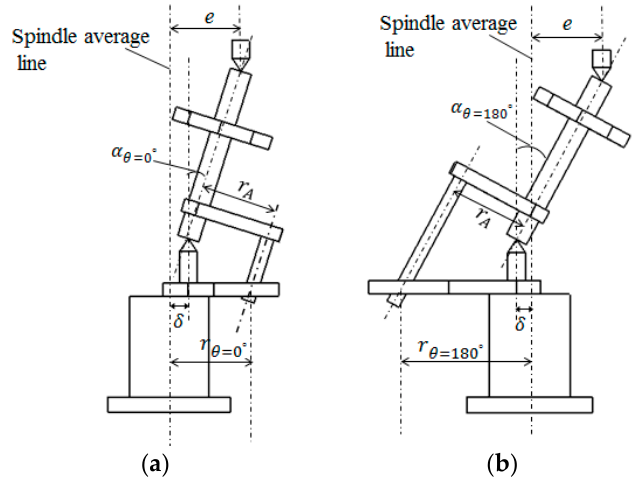
Figure 4. GMM with spindle error and coaxiality error: ( a ) θ = 0°; ( b ) θ = 180°.